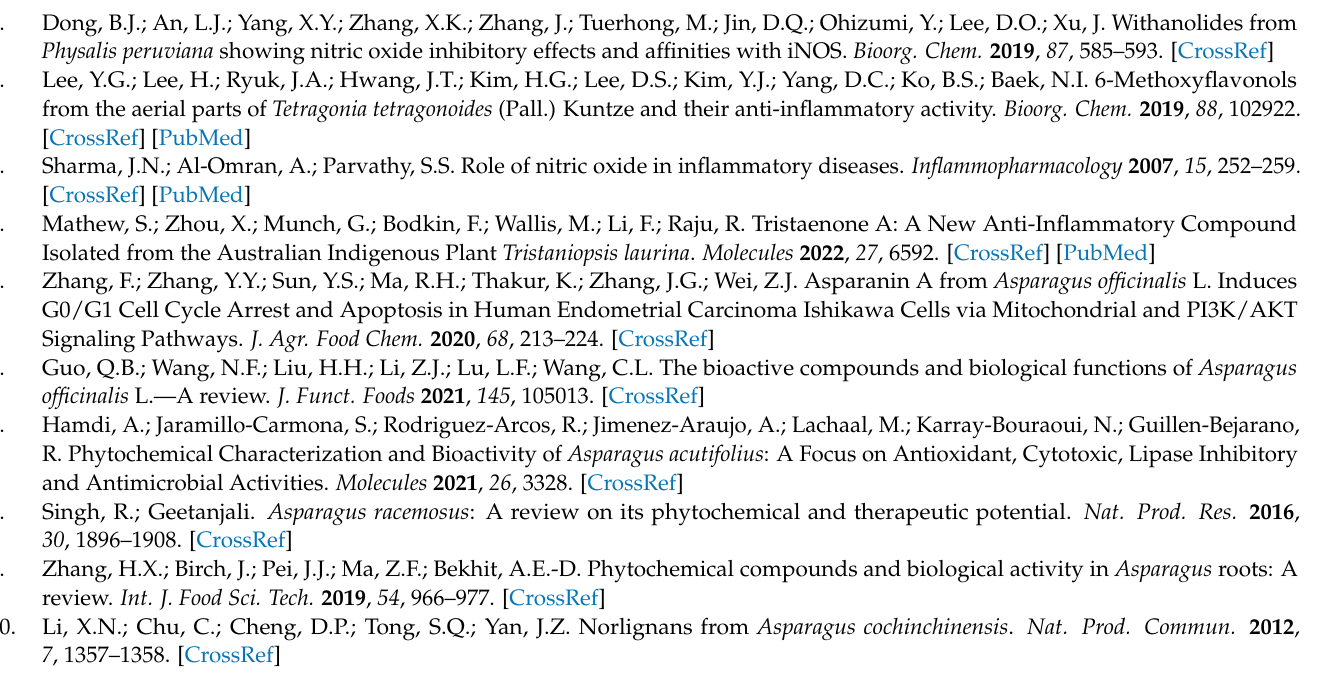
1. Figure S2.1. (-)-HRESIMS of compound 2. Figure S2.2. UV of compound 2. Figure S2.3. IR of compound 2. Figures S2.4–S2.9. NMR spectra of compound 2. Figure S3.1. (-)-HRESIMS of compound 3. Figure S3.2. UV of compound 3. Figure S3.3. IR of compound 3. Figures S3.4–S3.9. NMR spectra of compound 3